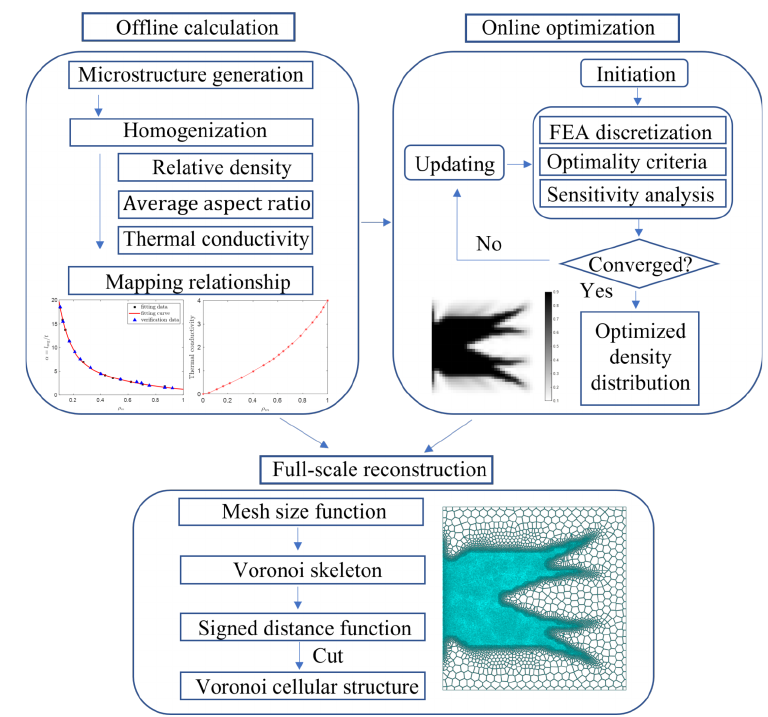
Figure 1. Flow chart of the design process of the